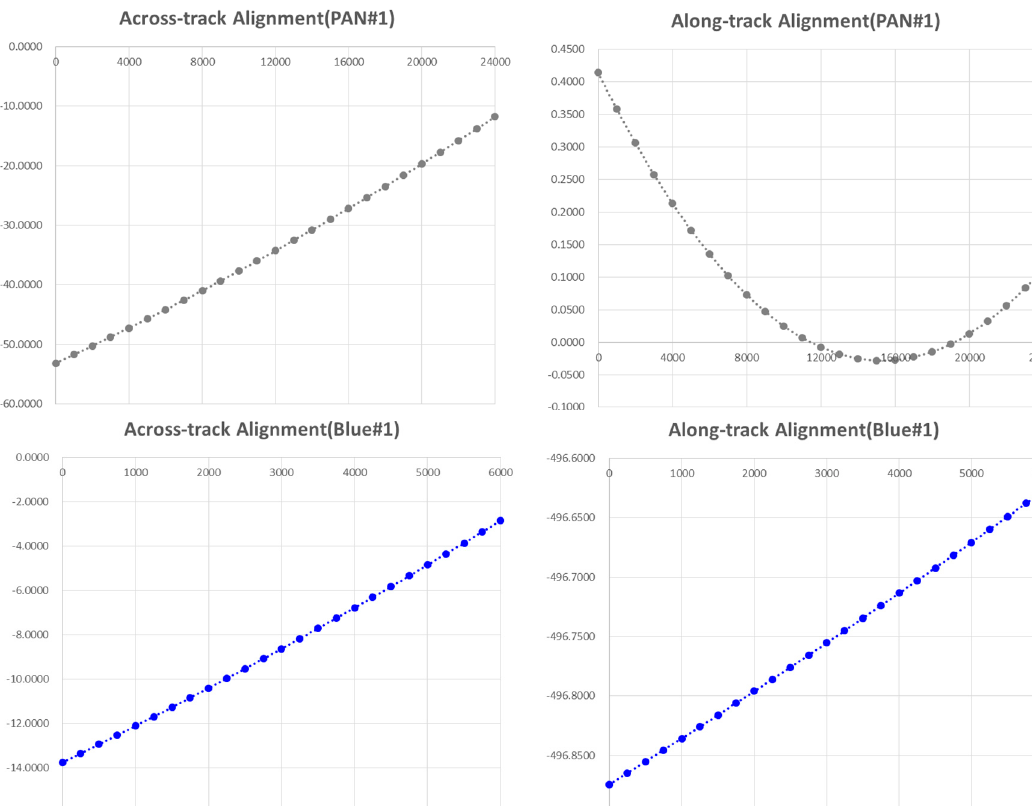
Figure 7. CCD alignment plots for PAN#1 and BLUE#1. Sensors 2016 , 16 , 1776